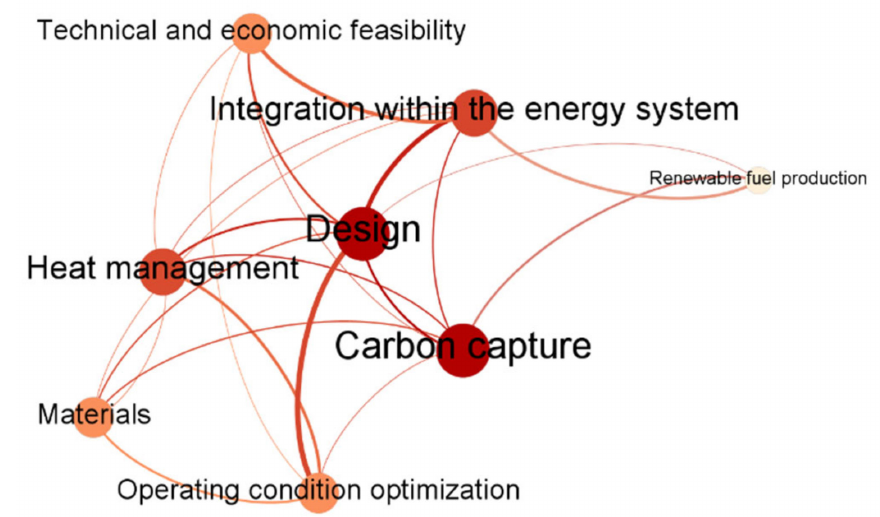
Figure 9. Network graph depicting the connections among research